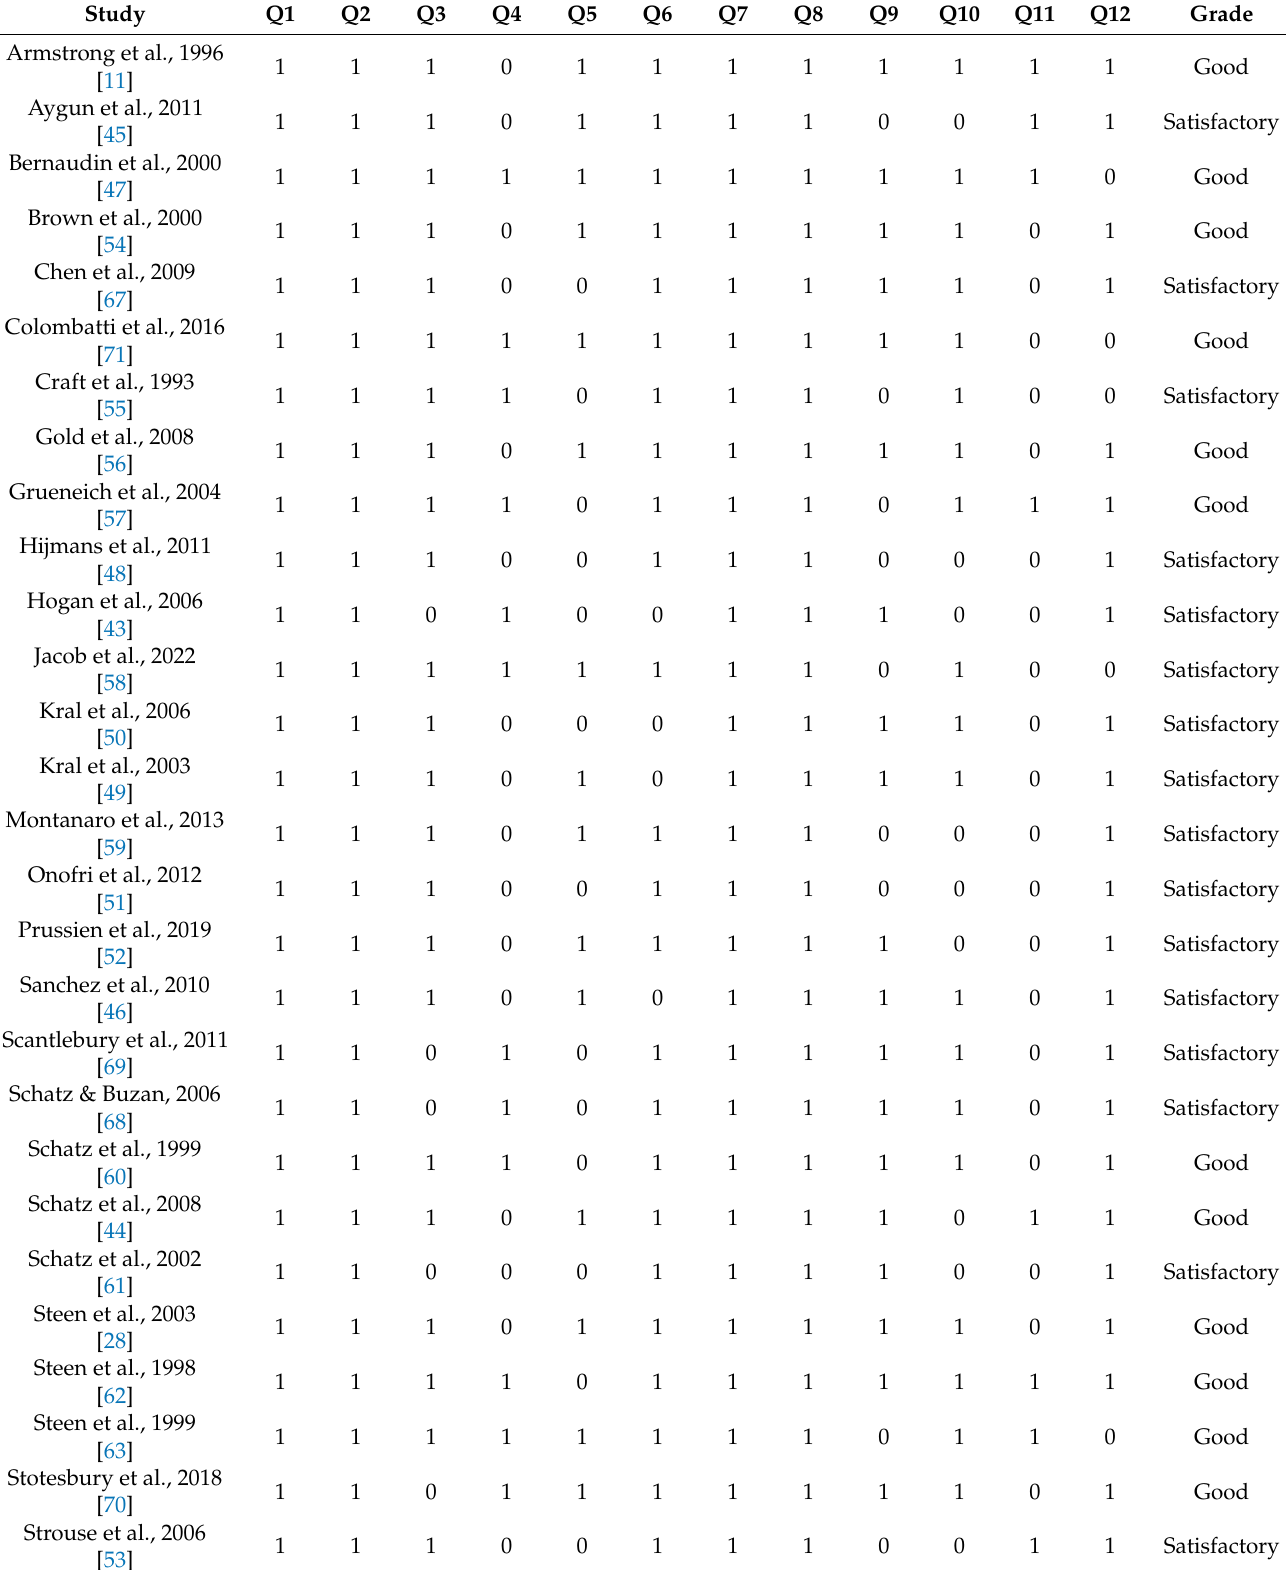
Table 4. Quality appraisal of studies included in the systematic